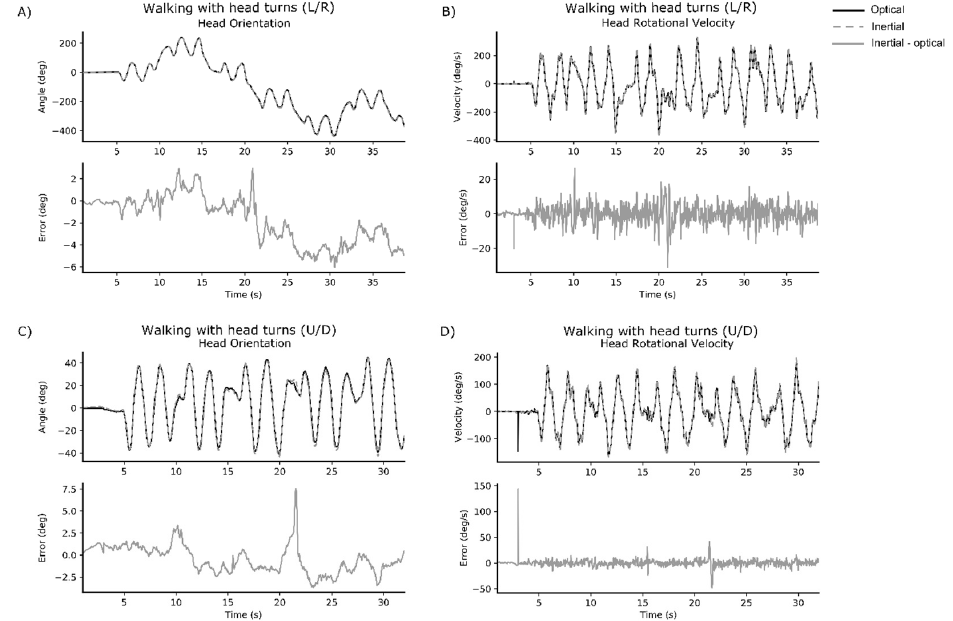
Figure 2. Representative time series data from one participant with mTBI. Each subplot provides the optical signal (black solid line) and IMU signal (grey dashed line) overlaid in the upper figure, and the error between optical and IMU signal below (grey solid line). Subplots represent: ( A ) head orientation for walking with head turns (L/R); ( B ) peak rotational velocity of the head for walking with head turns (L/R); ( C ) head orientation for walking with head turns (U/D); and ( D ) peak rotational velocity of the head for walking with head turns (U/D).